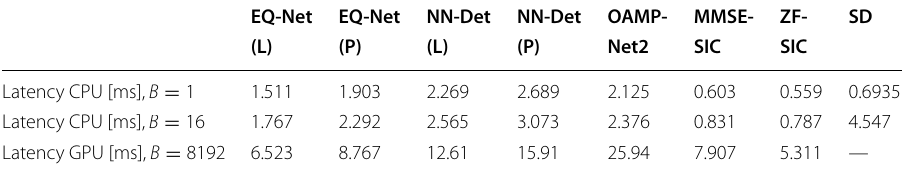
Table 2 Latency benchmarks of evaluated soft-output MIMO detection algorithms for a 2 × 2 , 64-QAM scenario. B represents the batch size during parallelized inference. All values are expressed in milliseconds and represent average execution times for the entire batch